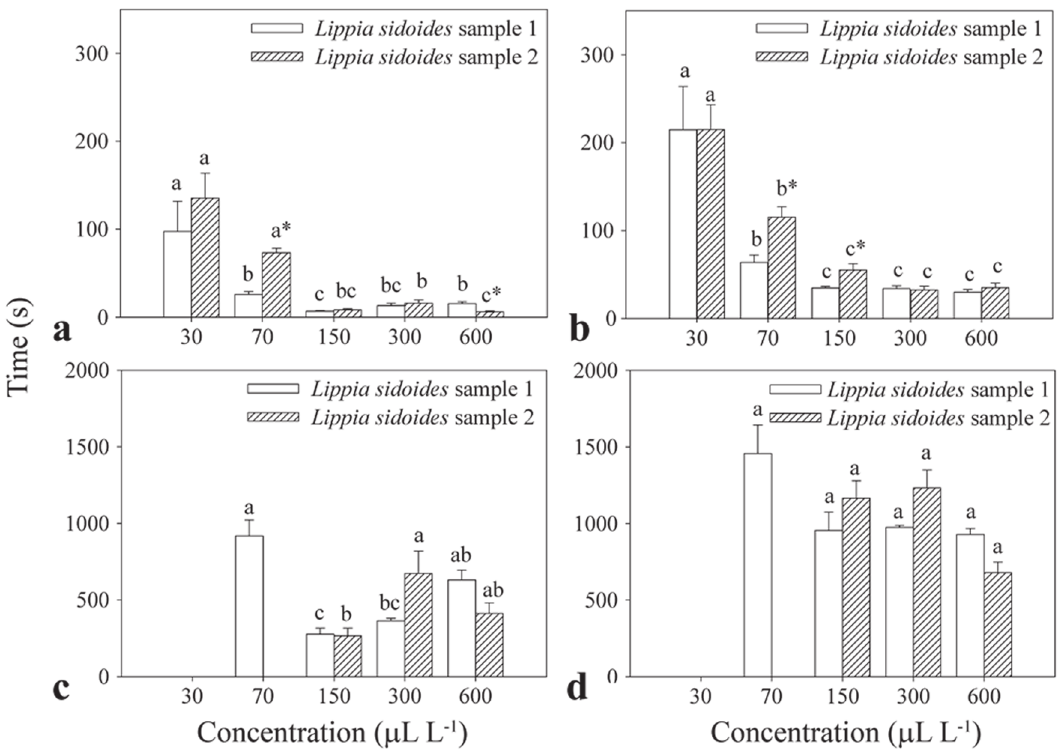
Fig. 2. Anesthetic effect of essential oils obtained from Lippia sidoides in silver catfish juveniles: a = Stage 2; b = Stage 3a; c = Stage 3b; d = Stage 4, according to Schoettger & Julin (1967). Maximum observation time for induction was 30 min. Data are presented as mean±SEM (N = 6). Different letters indicate significant differences among concentrations within each sample and * describes significant differences among samples